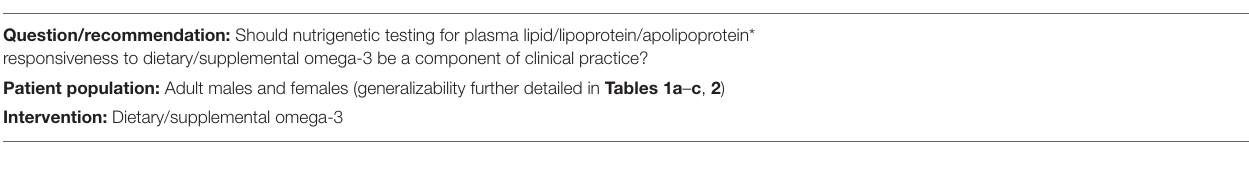
TABLE 1 | Evidence to recommendations framework.